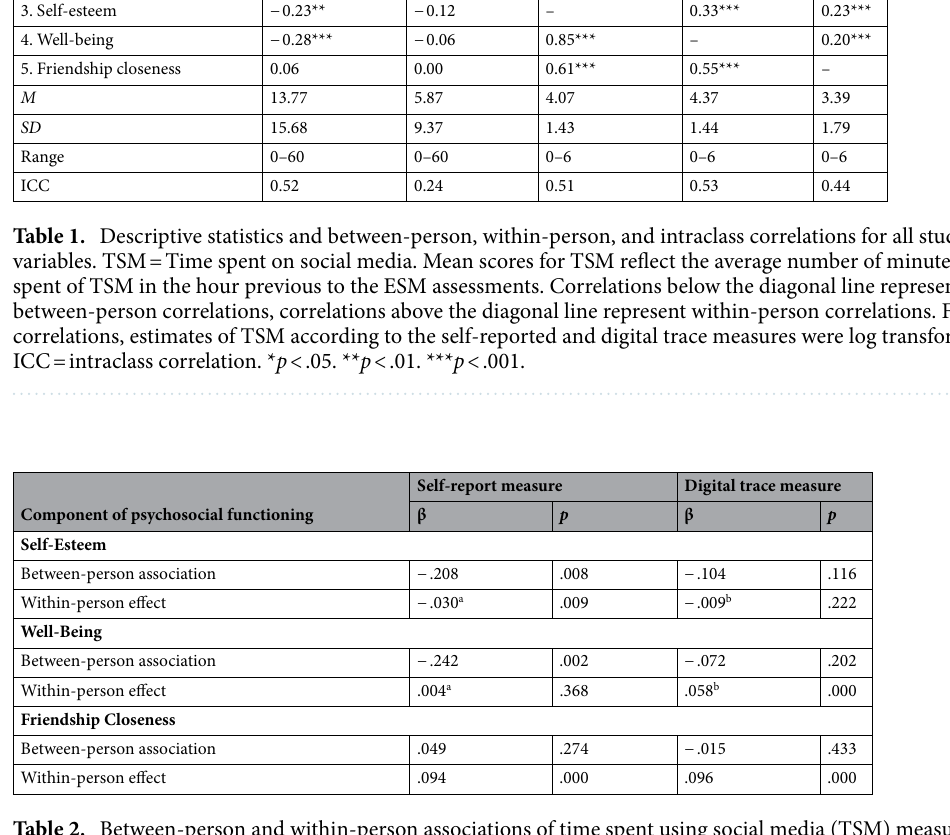
Table 2. Between-person and within-person associations of time spent using social media (TSM) measured via self-reported and digital trace measures with self-esteem, well-being, and friendship closeness. βs are standardized using the STDYX Standardization in Mplus. p -values < .025 are significant. βs within rows that do not share the same superscript ( a,b ) are significantly different across self-reported and digital trace measures of TSM in a t -test ( p < .017; corrected for multiple